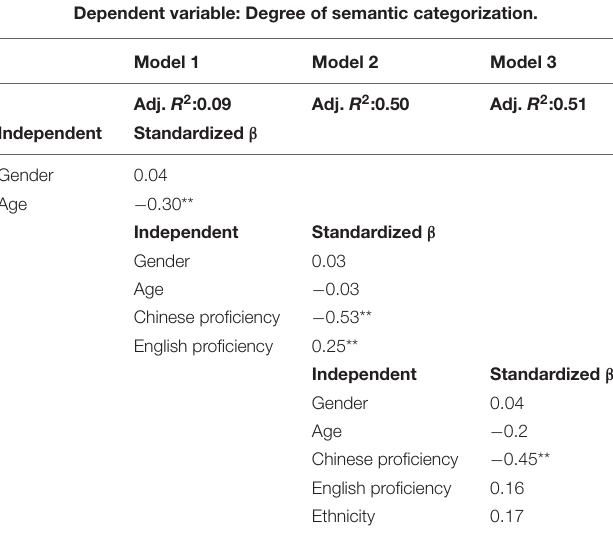
TABLE 5 | Prediction of semantic lexical classification in hierarchical regression. Dependent variable: Degree of semantic